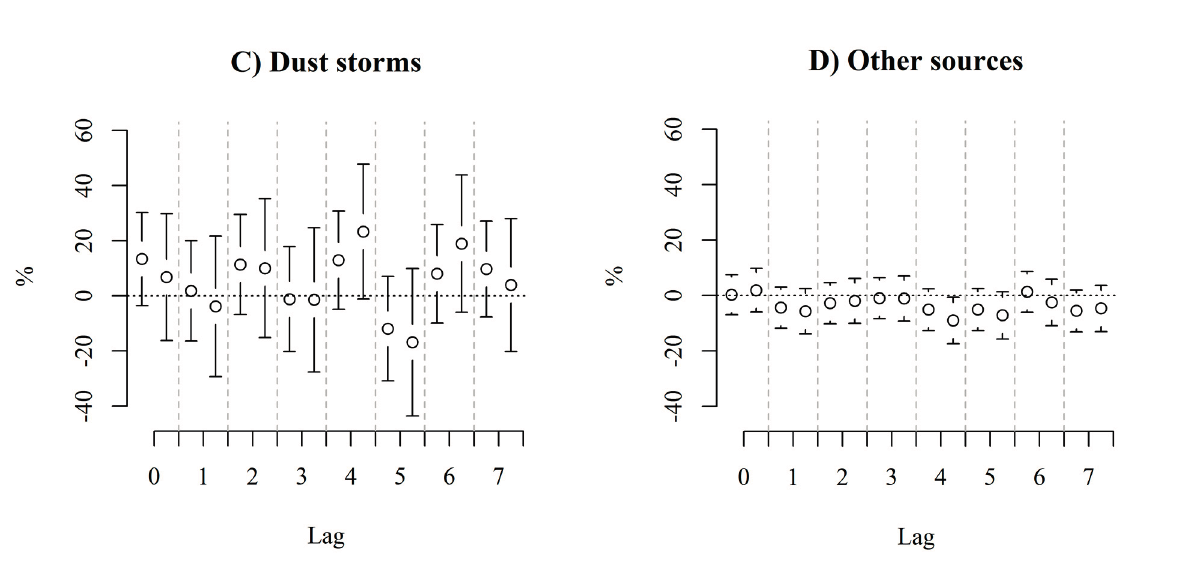
Figure 2. Associations between adult emergency hospital visits and indicators for PM 10 over air quality guideline value due to ( A ) any source, ( B ) volcanic ash, ( C ) dust storms, ( D ) other sources. The effect estimates are shown unadjusted (left) and adjusted for PM 10 , NO 2 and H 2 S